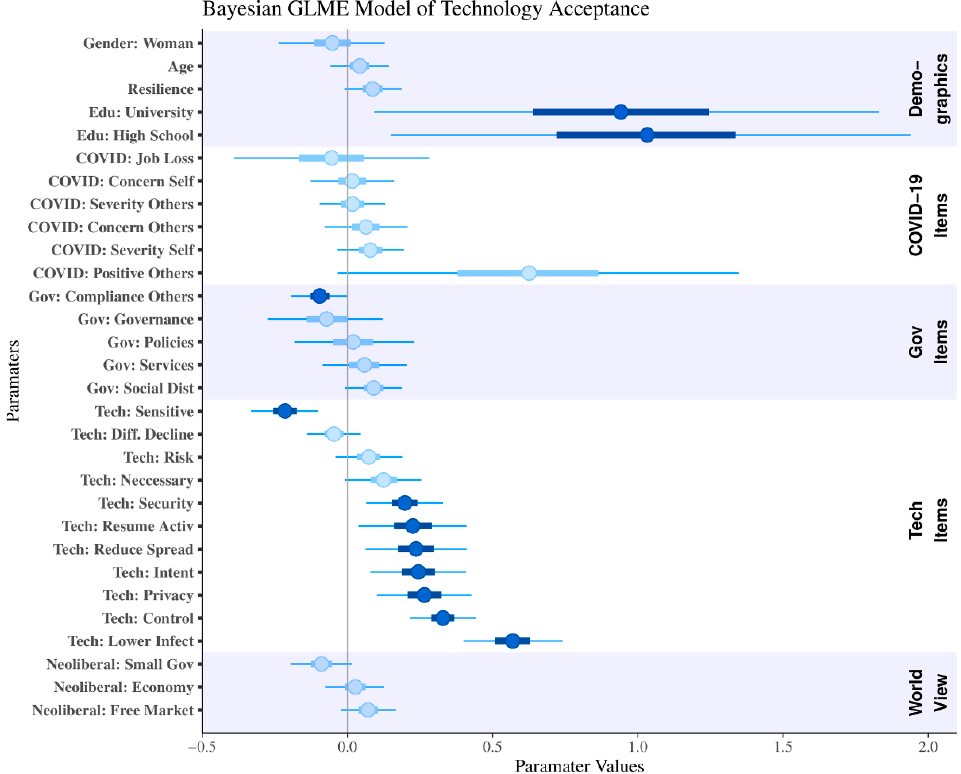
Figure 5. Bayesian generalized linear mixed effects model of tracing technology acceptance. Bars represent 50% of the parameter distribution centered on the parameter mean, tails display the 95% highest density interval. Opaque variables show instances where the posterior interval does not overlap zero.